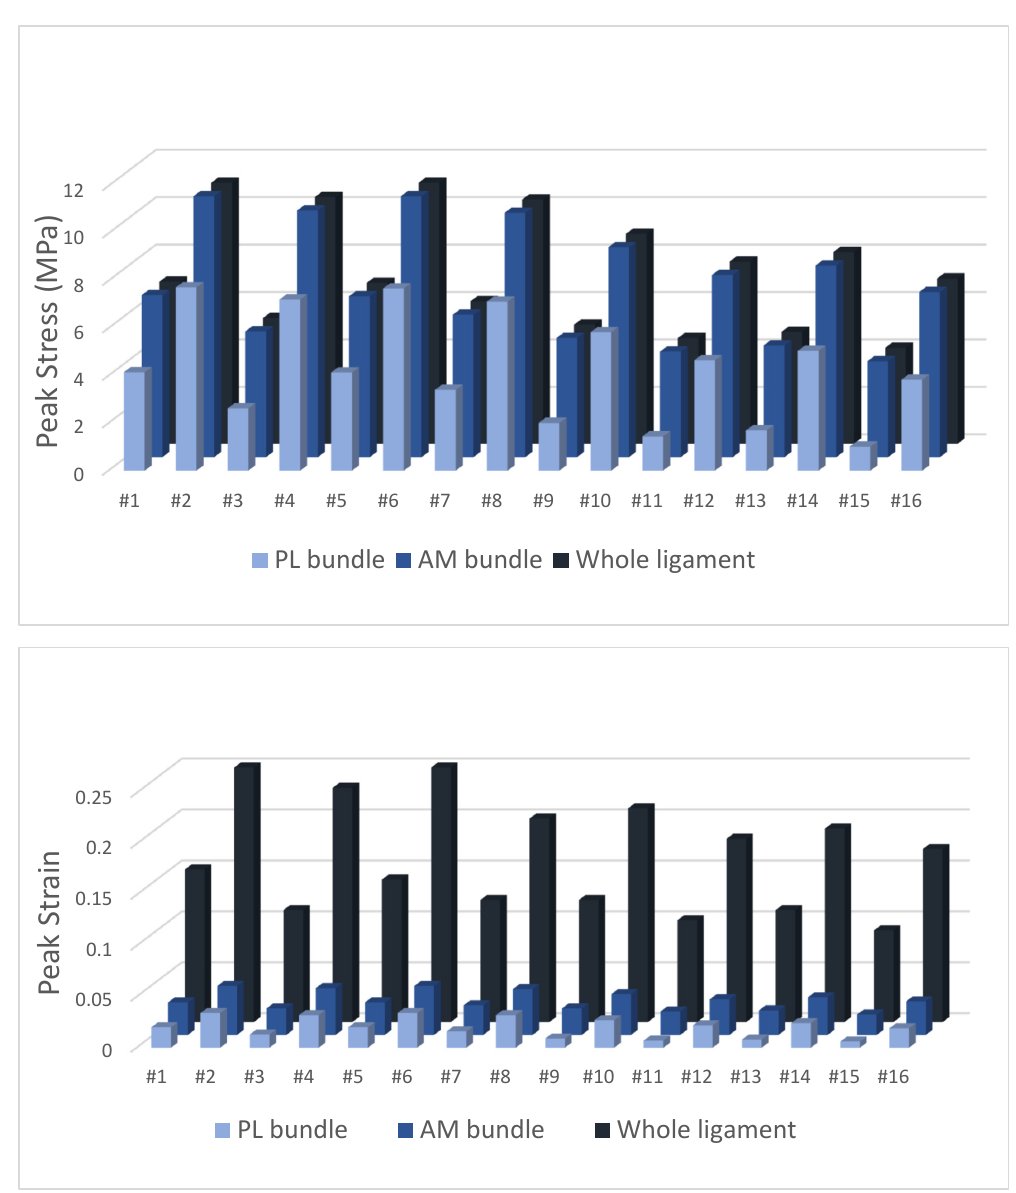
Figure 5. Output of peak stress and strain for the whole ACL ligament and AM/PL bundles.